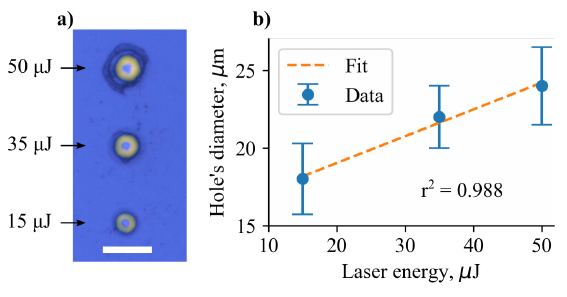
Figure 2. ( a ) Optical image of microperforations obtained at different laser energies. Scale is 50 µm. ( b ) The dependence between laser energy and produced hole diameter for the PLGA-based MB-loaded films. Ten holes were produced at each laser energy and their diameters were averaged to obtain a mean